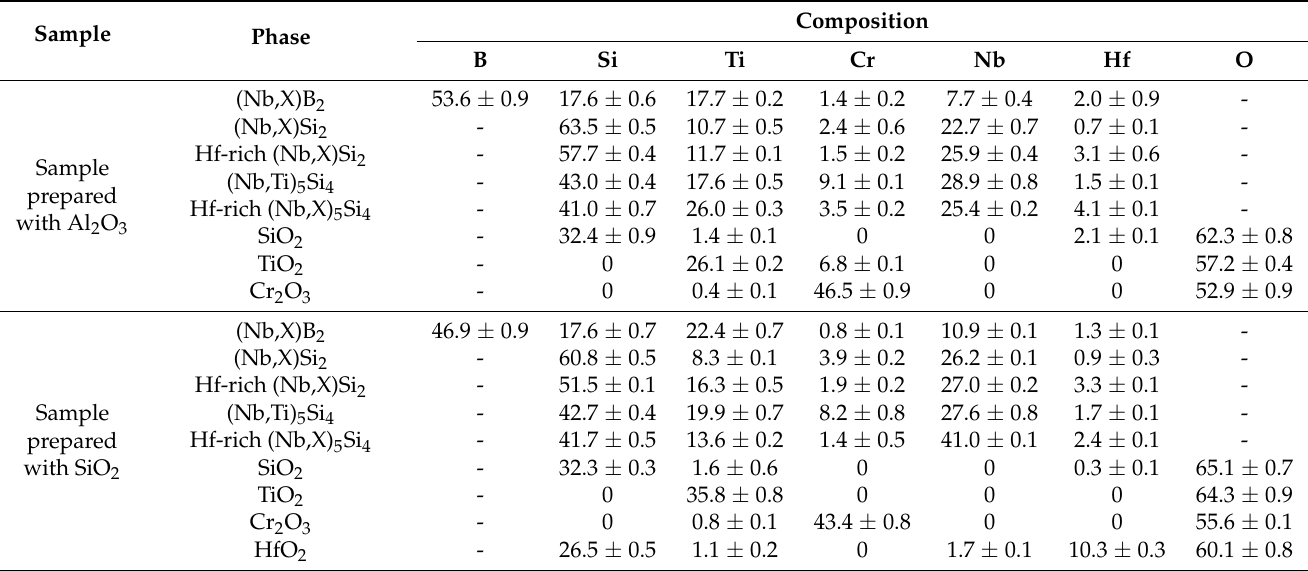
Figure 7. BSE image of cross-section morphologies of oxidized B modified silicides coatings prepared with Al 2 O 3 ( a – c ) and SiO 2 ( d – f ) after oxidation at 1250 ◦ C for 1 h ( a , d ), 10 h ( b , e ), and 100 h ( c , f ). Table 2. Element composition (at.%) of B modified silicides coatings prepared with Al 2 O 3 and SiO 2 filler after oxidation at 1250 ◦ C for 100